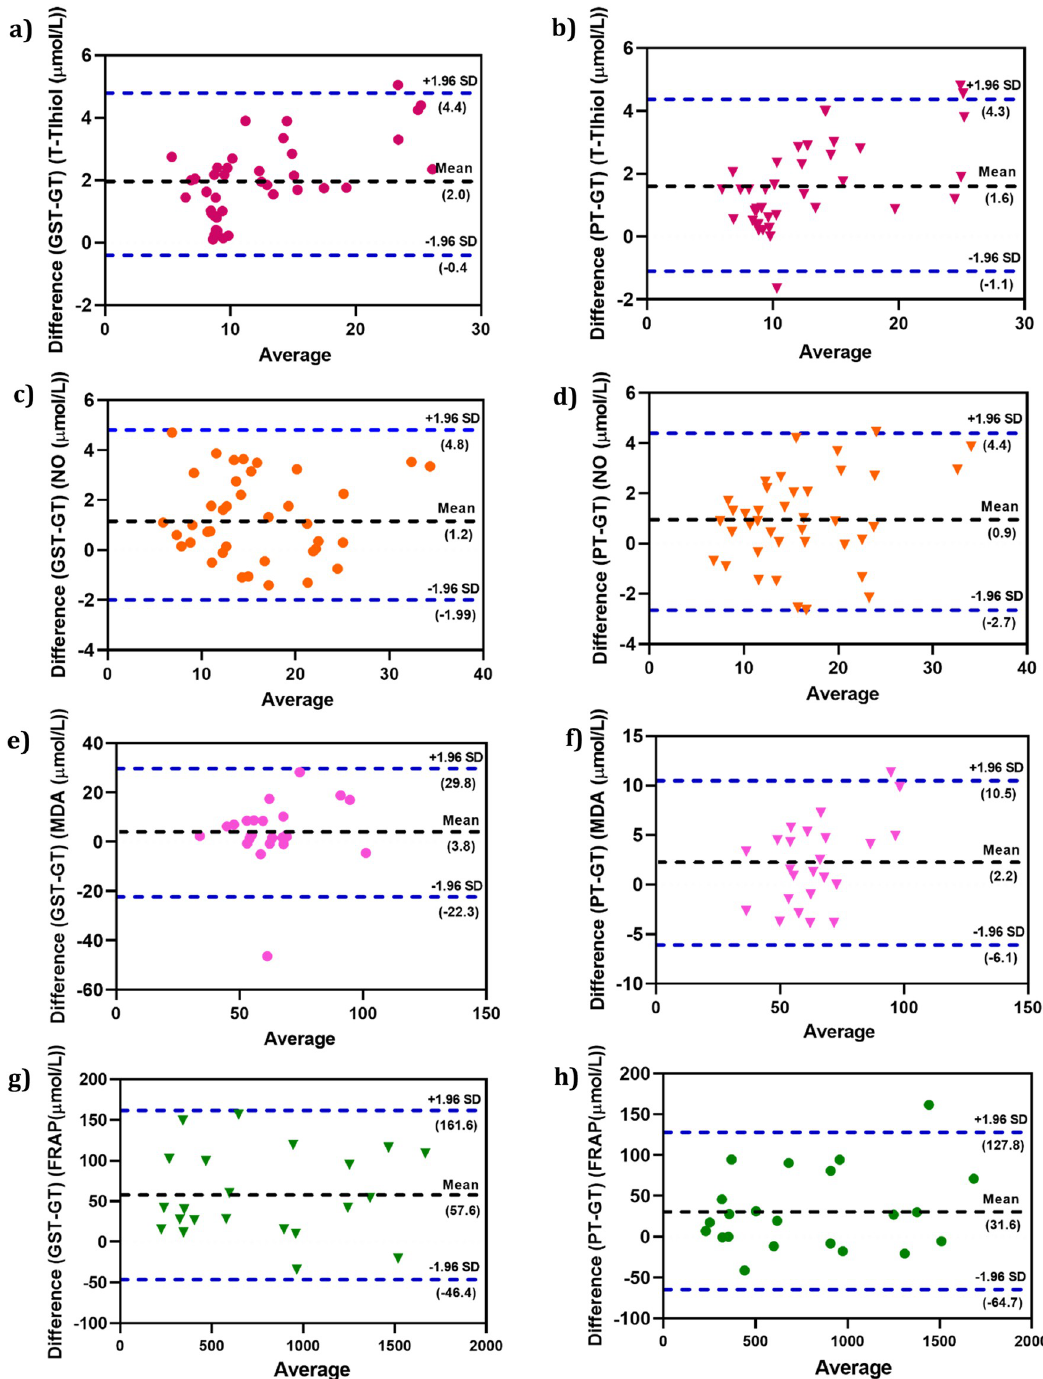
Fig 3. Bland-Altman difference plots for the antioxidant parameters obtained with PT, GST and GT tubes. (a, b) total Thiol, (c, d) NO, (e, f) MDA, (g, h) FRAP values. The dashed lines are the limit of agreements (LOA), which correspond to the mean ± 1.96 SD of the difference between the